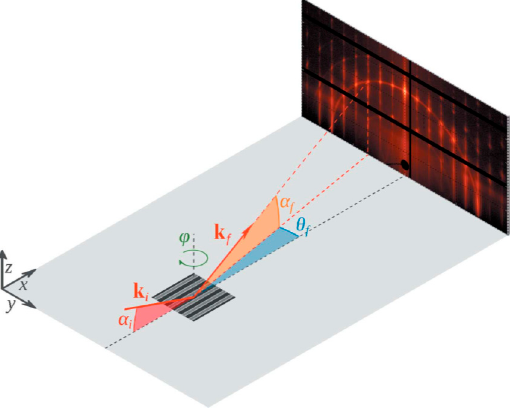
Figure 38. Geometry of GISAXS experiments [252].